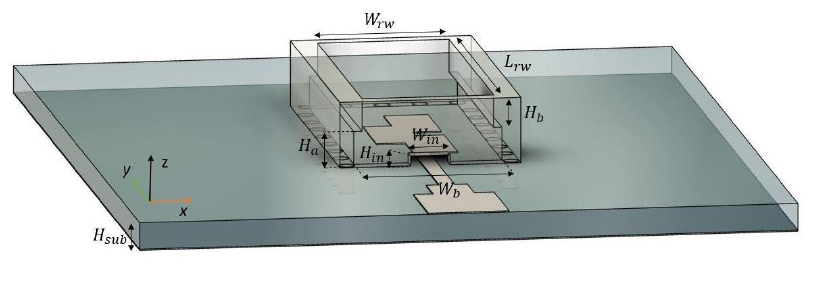
Figure 1. Top view of the transition.